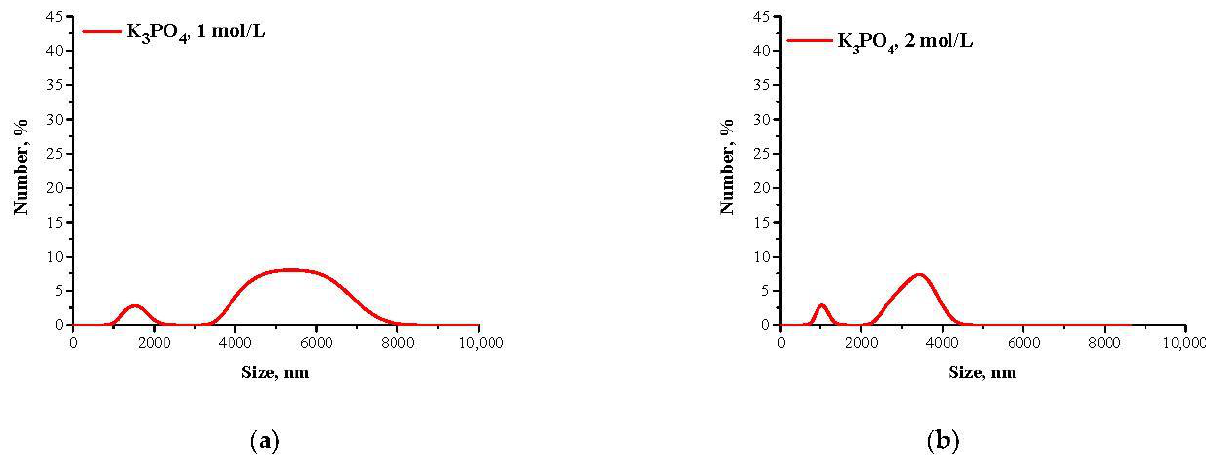
Figure 2. DLS analysis of particles obtained using Tris-HCl buffer with pH = 4.8 and 1 mol/L K 3 PO 4 ( a ) or 2 mol/L K 3 PO 4 ( b ) as a salting-out agent.